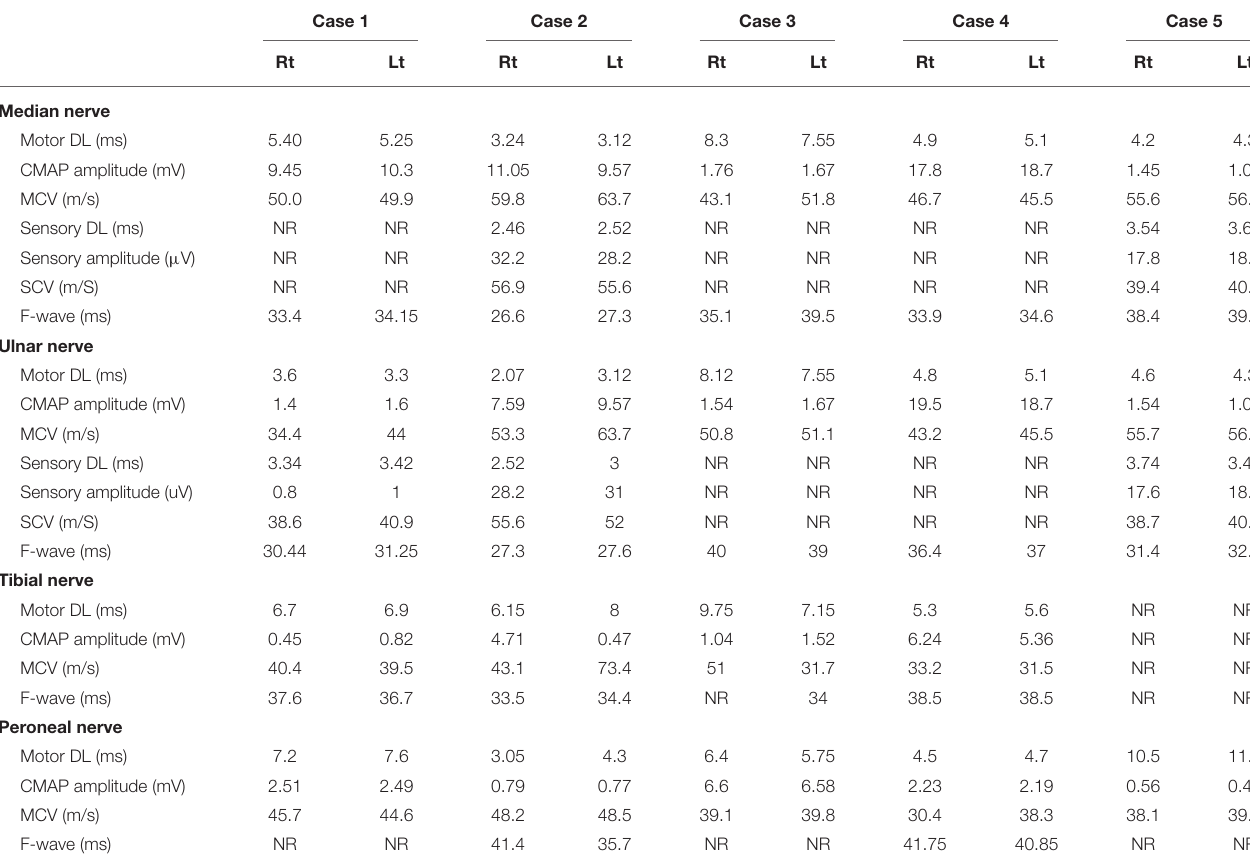
TABLE 2 | Neurophysiological